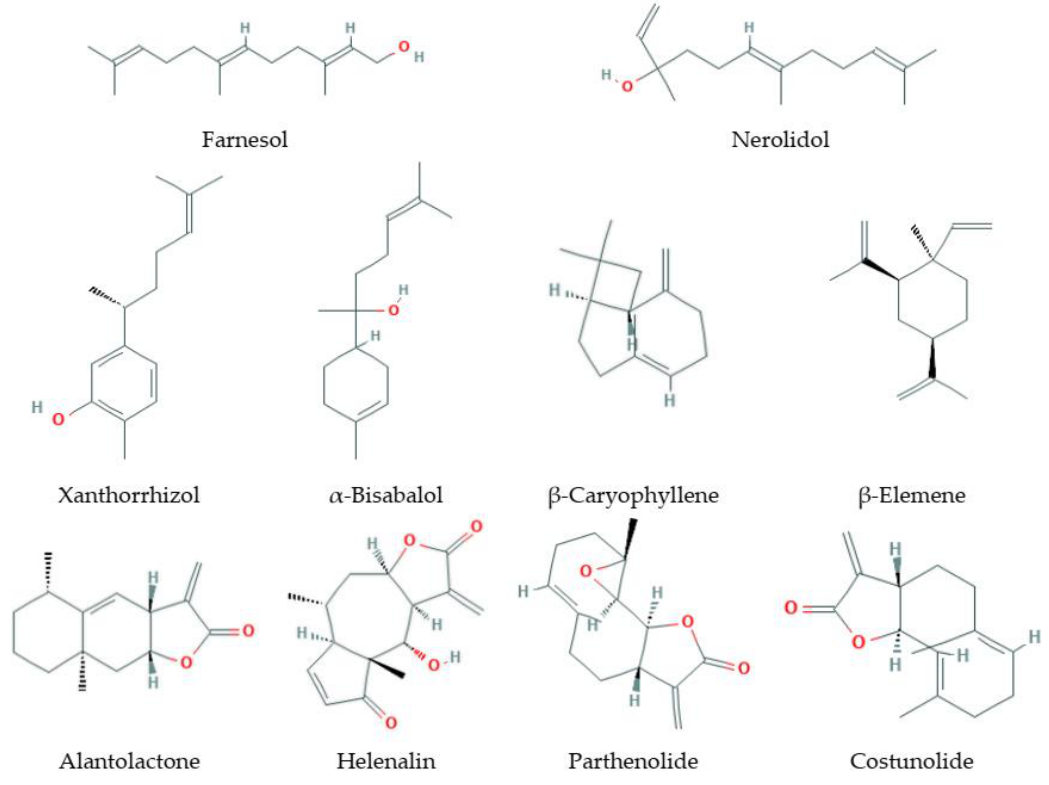
Figure 2. Some sesquiterpenes that increase lifespan and delay age-related diseases.